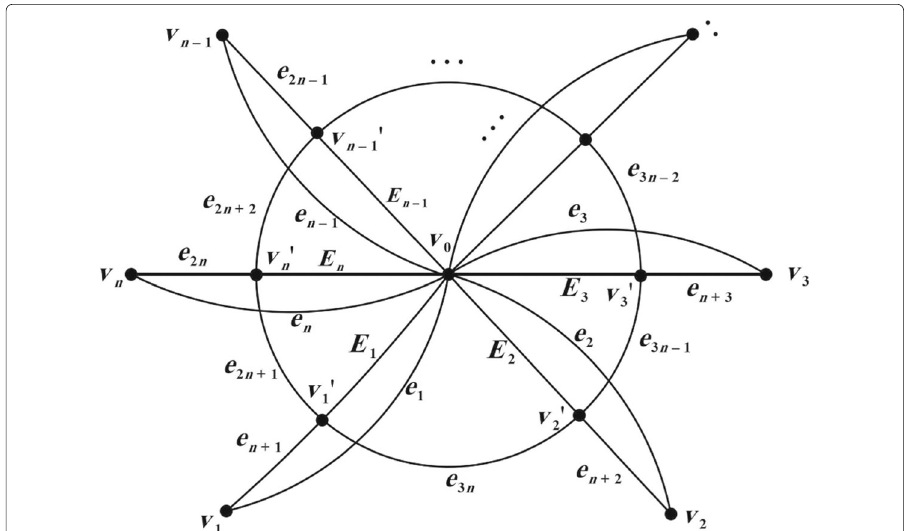
Fig. 20 The flower graph FL(n) with ordinary